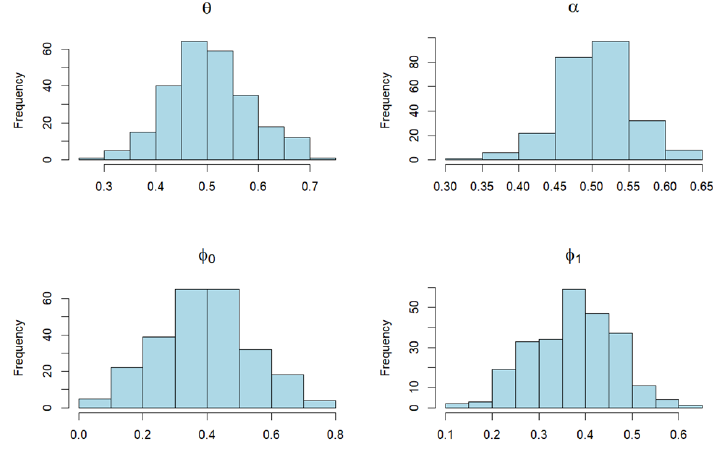
Figure 3. Histograms of empirical distributions of the PGF estimated parameters of the ZOIPS- INAR(1) process with zero-and-one inflated Poisson PS innovations. (Parameters are the same as in Table 2).